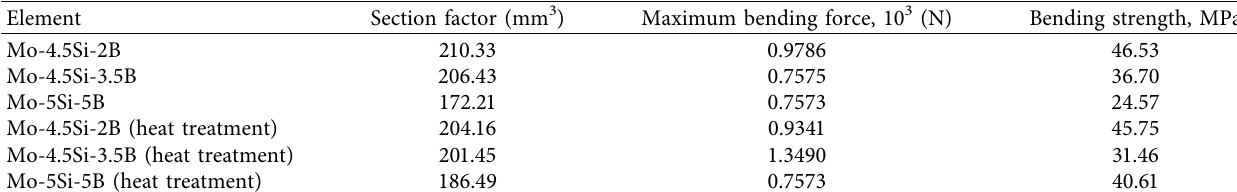
Figure 5: Three-point bending test of samples with different compositions ((a) without treatment and (b) after heat treatment). Table 5: Test sample bending strength under different components and